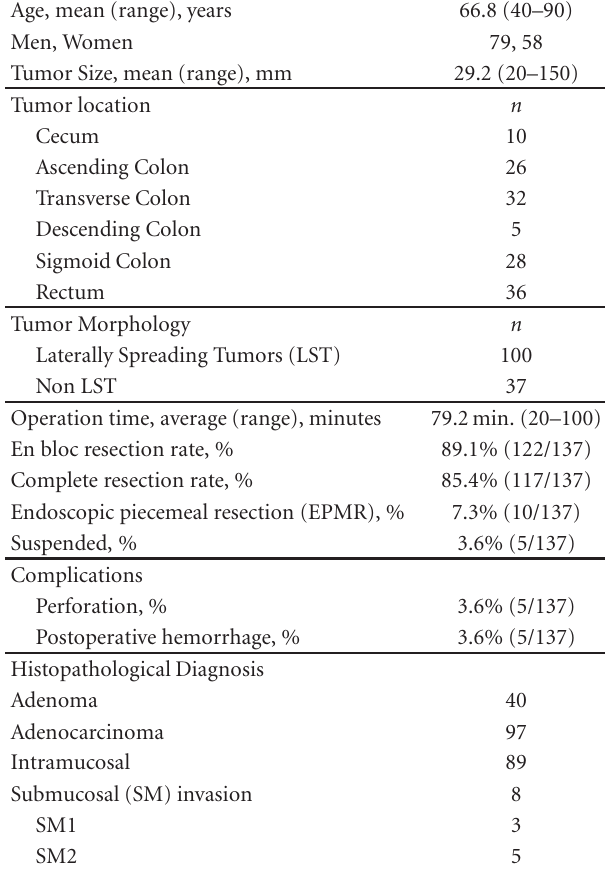
Table 1: Clinicopathologic characteristics of 137 superficial col- orectal